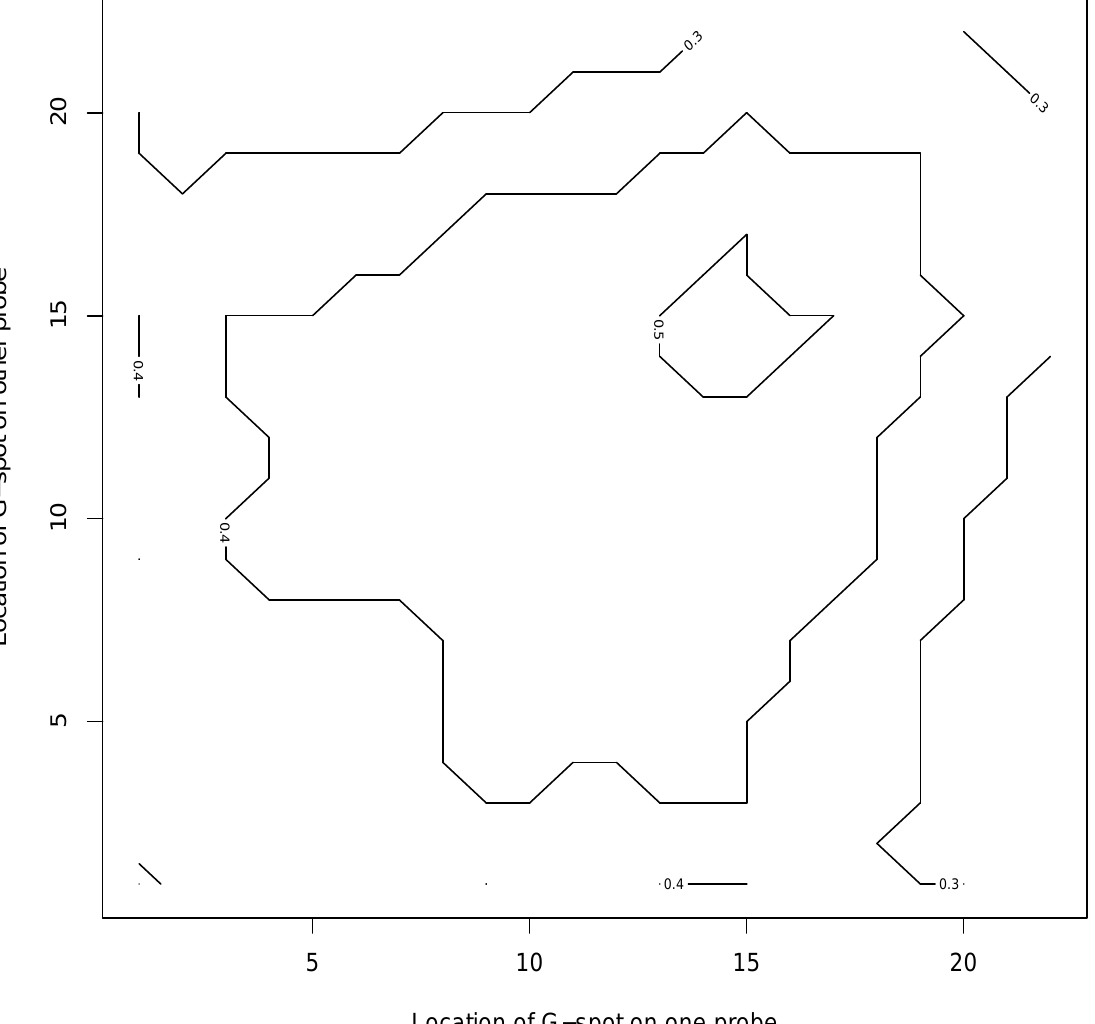
Figure 3: A contour plot showing the variation of the average correlation coefficient for pairs of probes containing 4G runs at different